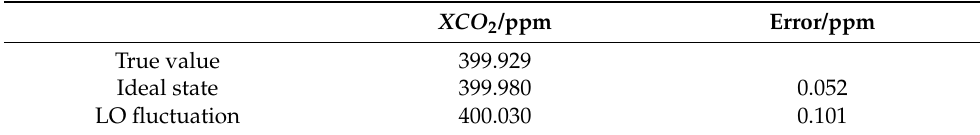
Table 4. Influence of LO fluctuations on retrieval results.